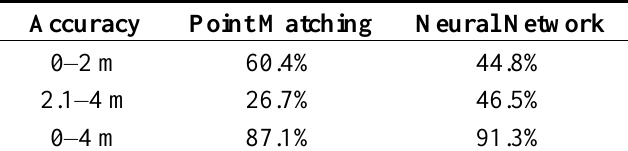
Table 5. Comparison of the neural network and the point matching method using the lowest MSE of the I_J_K combination.